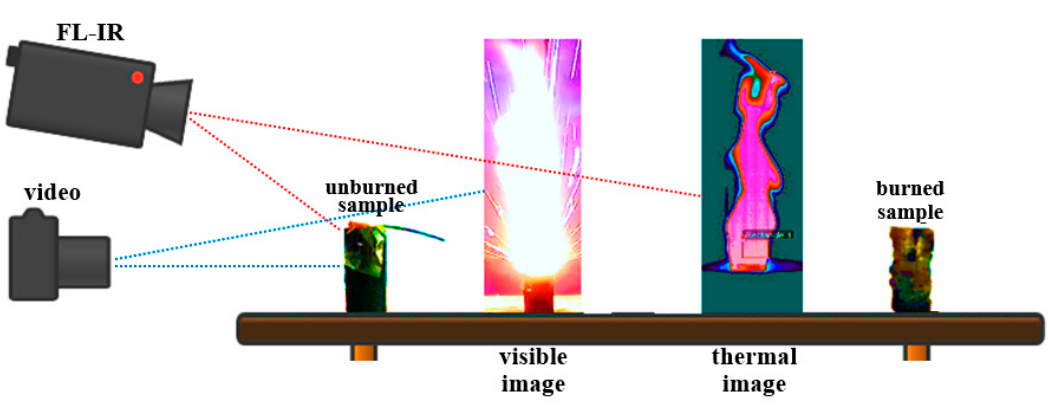
Figure 10. Setup for the burning tests at atmospheric pressure.